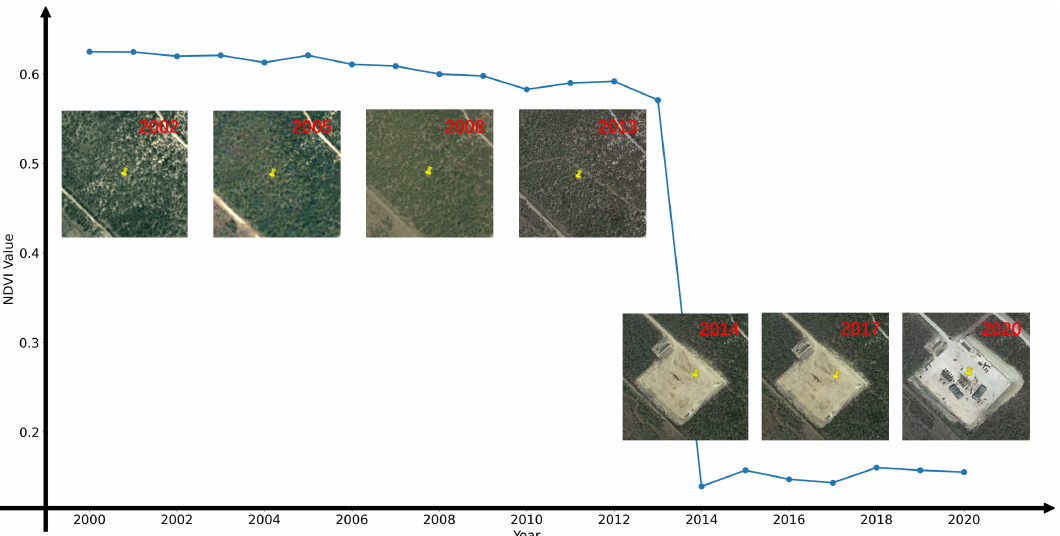
Figure 4. Changes in NDVI value and ground cover before and after shale oil/gas well construction from 2000 to